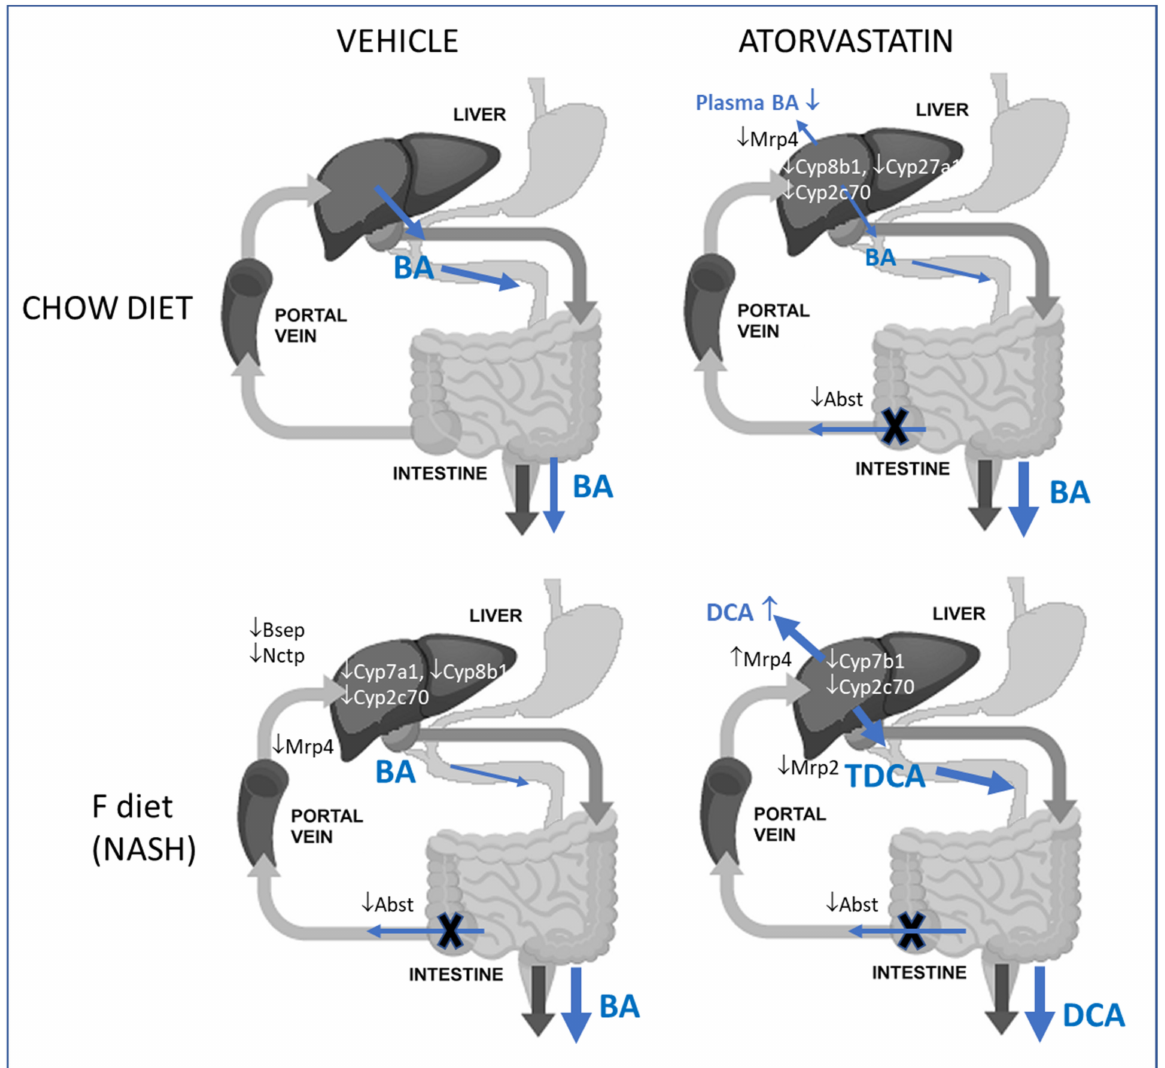
Figure 8. Possible mechanisms responsible for the effects of atorvastatin on BA metabolomics in mice with dietary-induced NASH. Changes induced by NASH and atorvastatin are depicted with arrows. The thickness of the blue arrow refers to the nature of change (increase or decrease) in the function vs. the corresponding untreated group. Abbreviations: BA—bile acids, Bsep—bile salt export pump; CD36—platelet glycoprotein 4, fatty acid translocase; DCA—deoxycholic acid; Mrp2/4—multidrug resistance–associated protein 2/4; Ntcp—Na + -taurocholate co-transporting